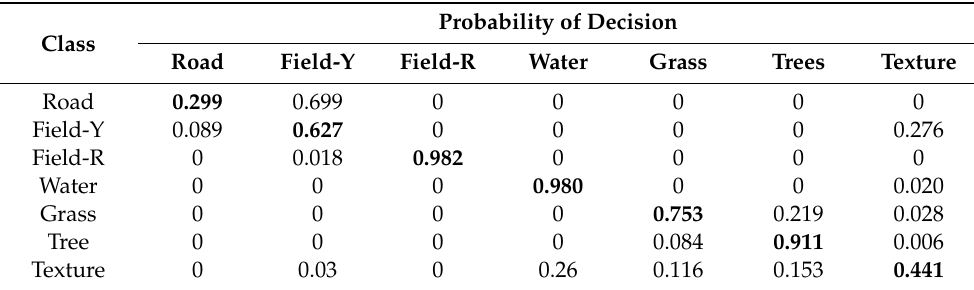
Table 7. Confusion matrix for compressed image classified by NN trained for the original image and applied for the compressed image (PSNR-HVS-M = 42 dB).